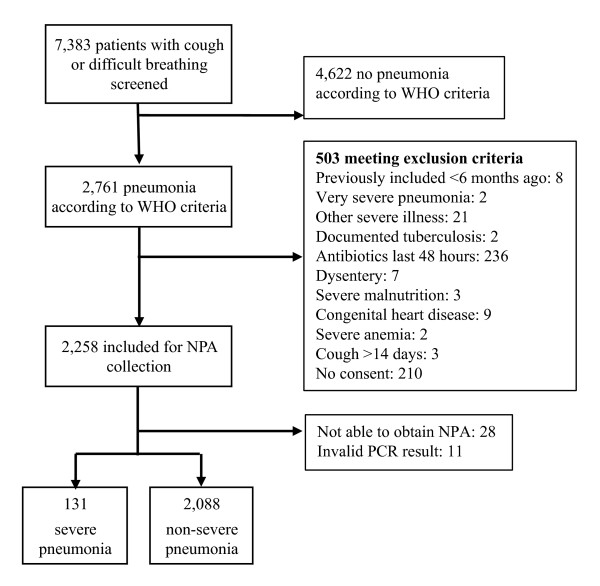
Study profile for children 2 to 35 months of age included in a study of viral community-acquired pneumonia in Bhaktapur, Nepal, from July 2004 to June 2007. Severe malnutrition was defined as <70% NCHS (National Center for Health Statistics) median weight for height. Severe anemia was defined as hemoglobin <7 g/dl.